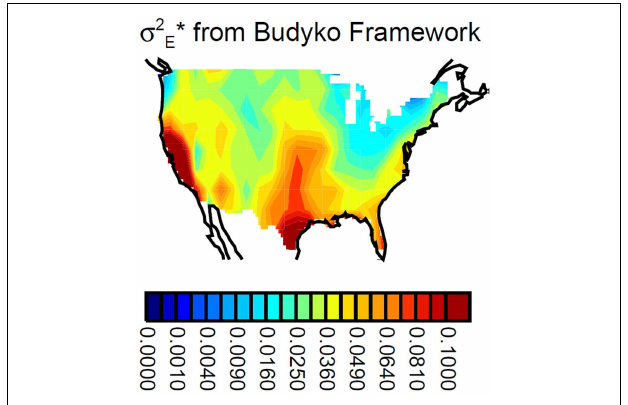
FIGURE 3 | Distribution of σ 2 E ∗ (mm 2 /day 2 ) as derived from the hydroclimatic analysis framework of Budyko